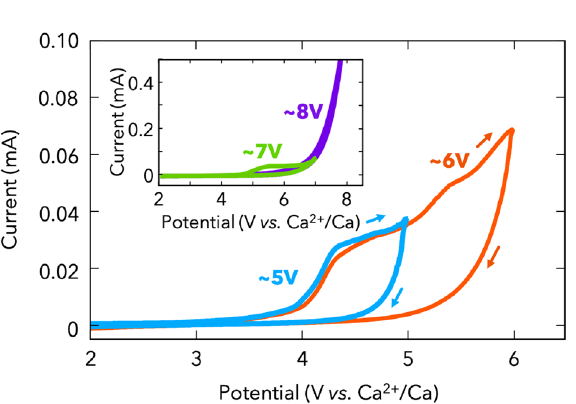
Figure 4. Cyclic voltammograms at 1 mV s −1 with different voltage ranges above 5 V (blue), 6 V (orange), 7 V (green), and 8 V (purple). Arrows indicate the sweeping direction during voltammetry. (d) Cycling performance of the Ca | CMC/DME/THF | Ca cell at a current density of 0.02 mA cm −2